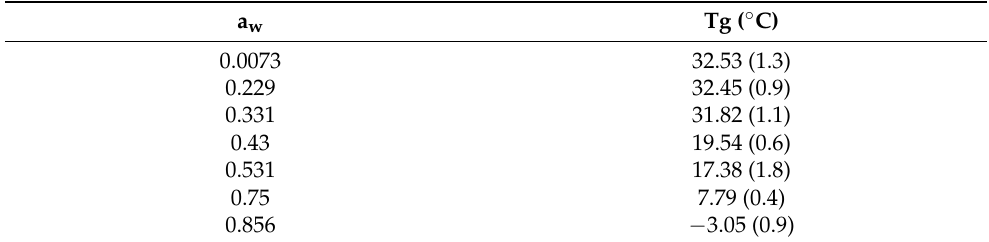
Table 1. Determined Tg values at different a w . The values represent the average of two measurements, and the standard deviation is indicated in